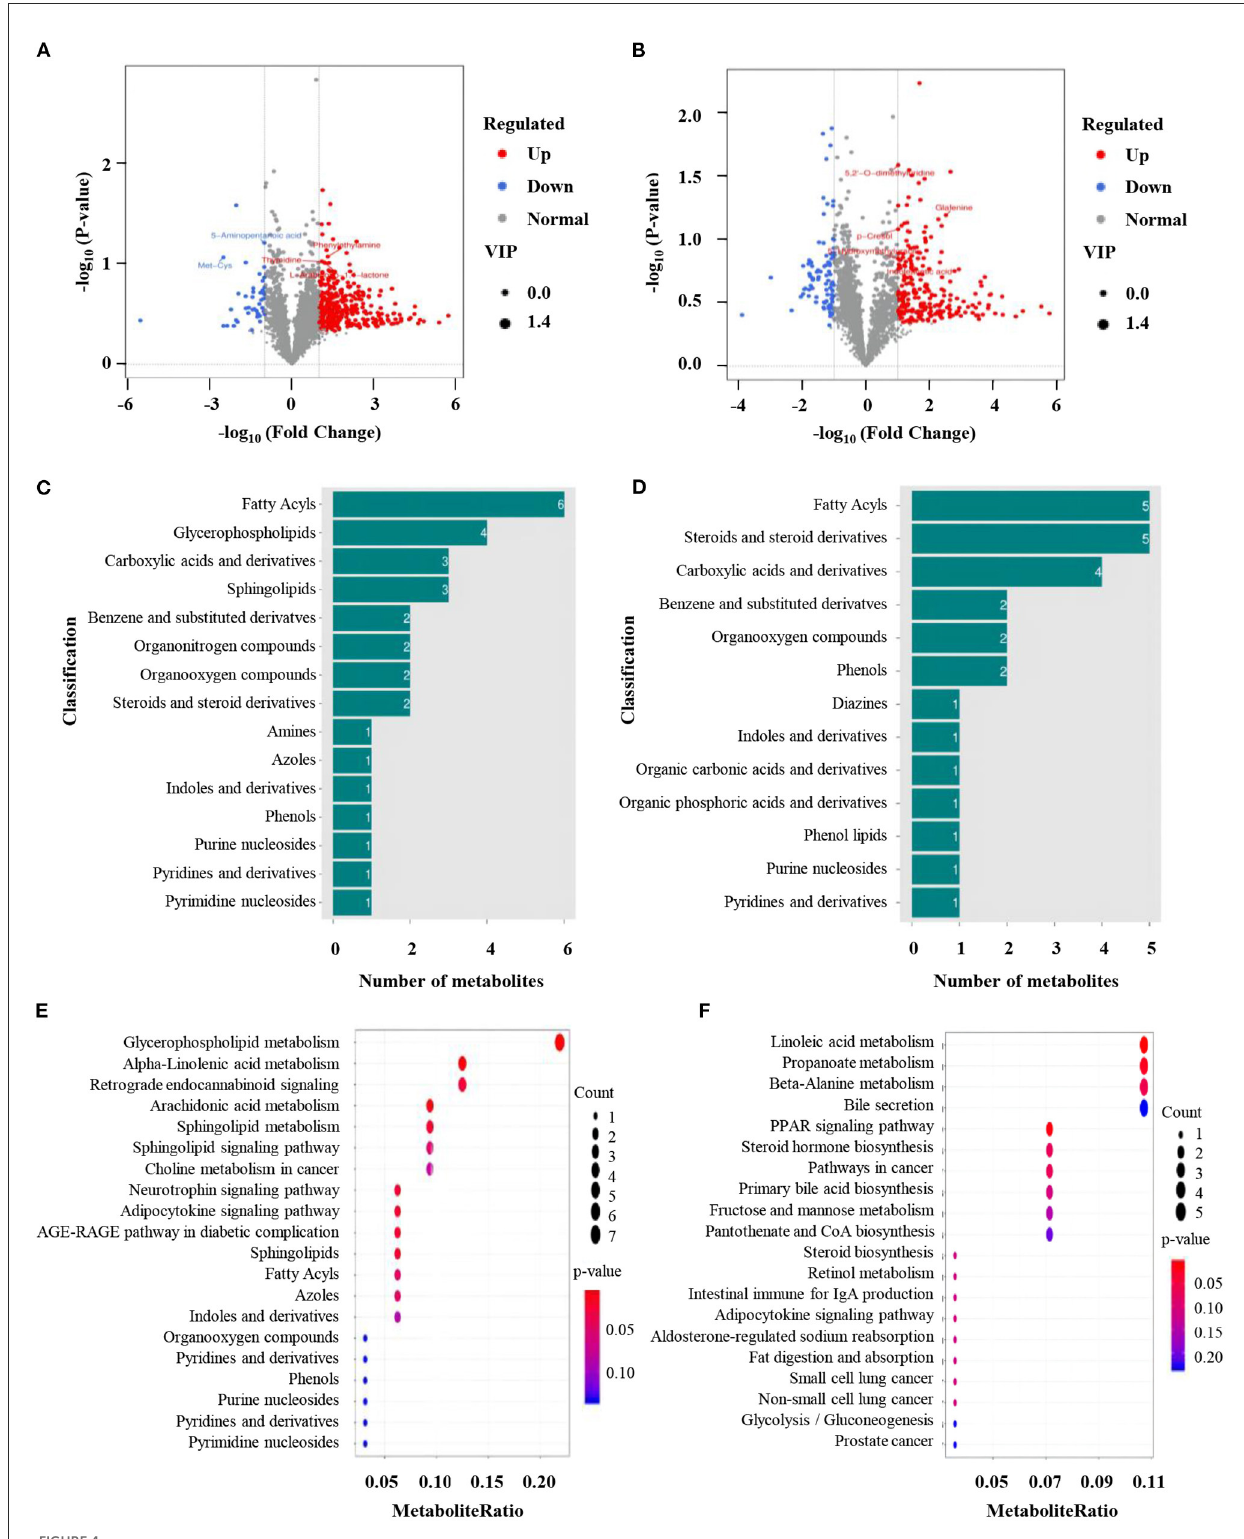
FIGURE4 Identification of differentially expressed metabolites. (A, B) Volcano plots of the differential metabolites between normal and low-quality semen group; (C, D) Gene ontology (GO) analysis of significantly changed metabolites from positive and negative model. (E, F) Kyoto Encyclopedia of Genes and Genomes (KEGG) pathway analysis of significantly changed metabolites from positive and negative